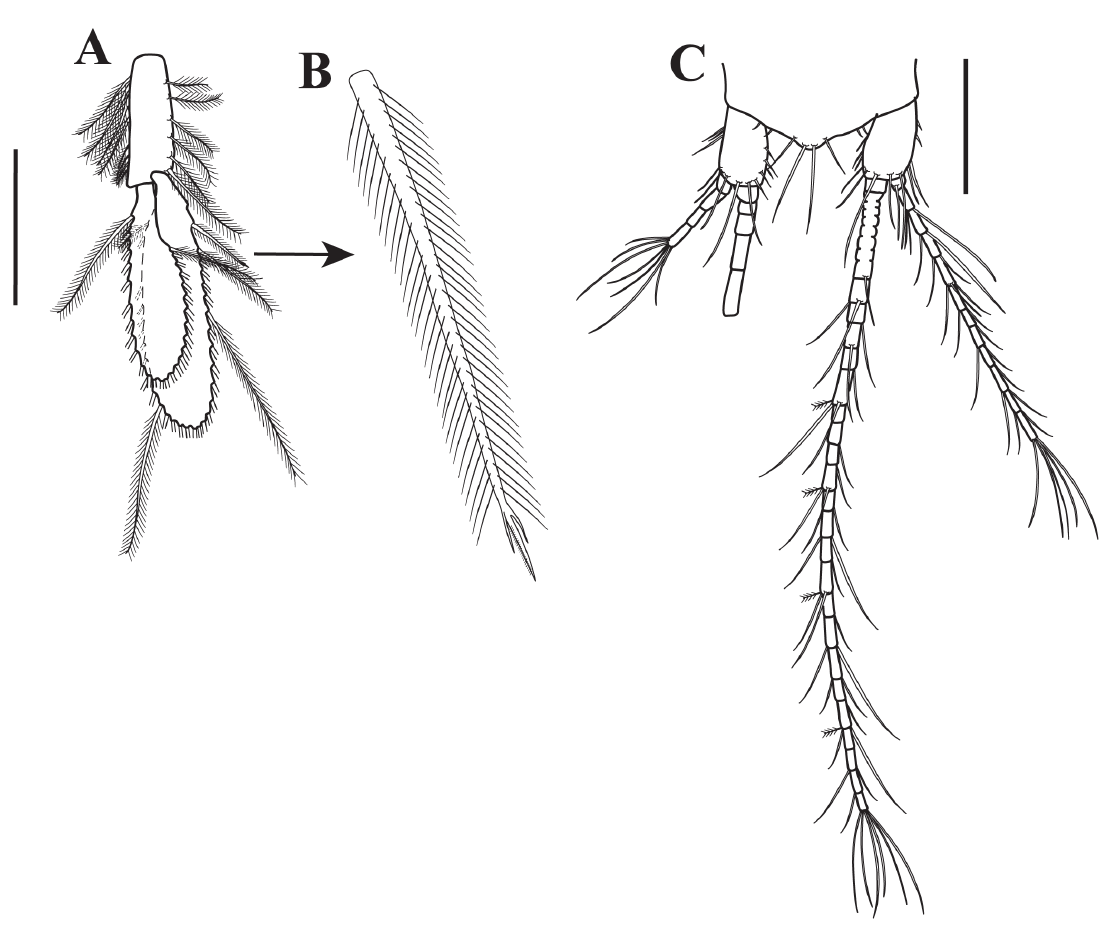
Figure 10. Brachylicoa lui sp. n. holotype female with oostegites and genital cone. A pleopod; B enlargement of plumose seta with whiplike serrate tip; C uropod. Scale bars = 0.5 mm for A , C . Table 1. TL, mean ± SE, and comparison of morphological features of sexual stages of Brachylicoa lui sp. n. from the Naval ex- perimental site